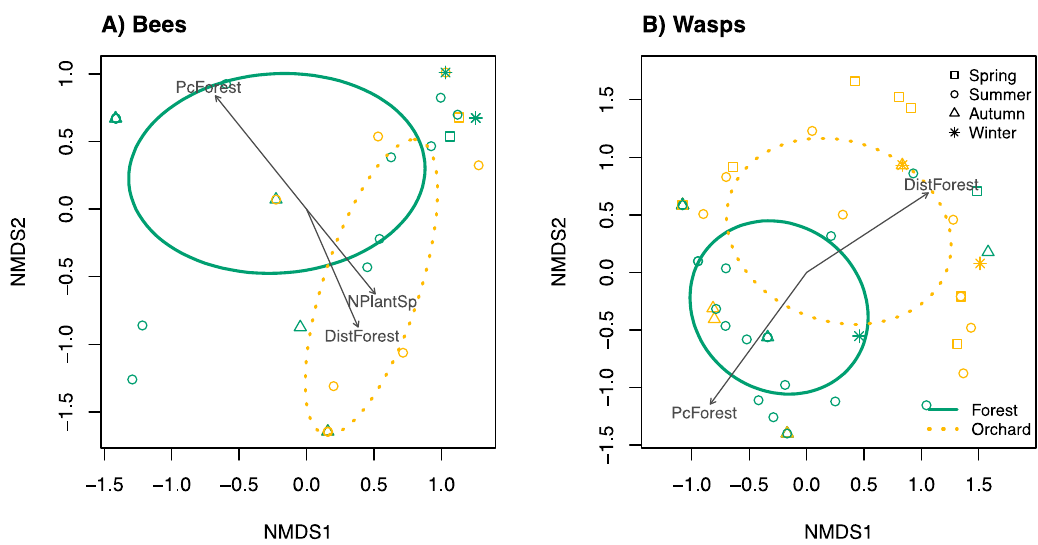
Figure 2. Changes of bee ( A ) and wasp ( B ) communities with landscape simplification and seasonal